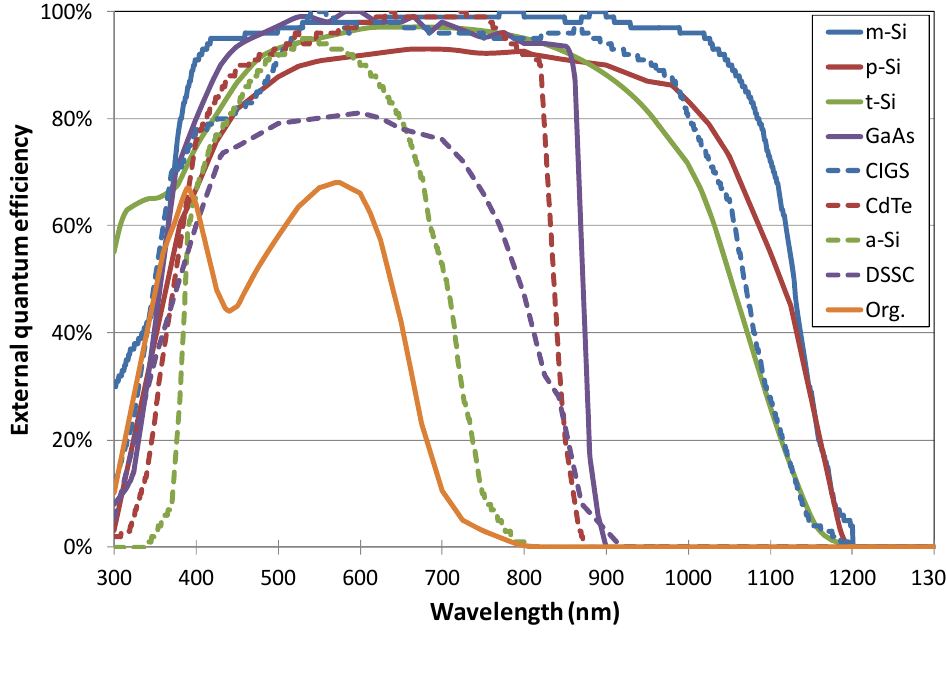
Figure 4. The external quantum efficiency of the different types of photovoltaic solar cells considered, as found in the references of Table 1. We refer to Table 1 for the